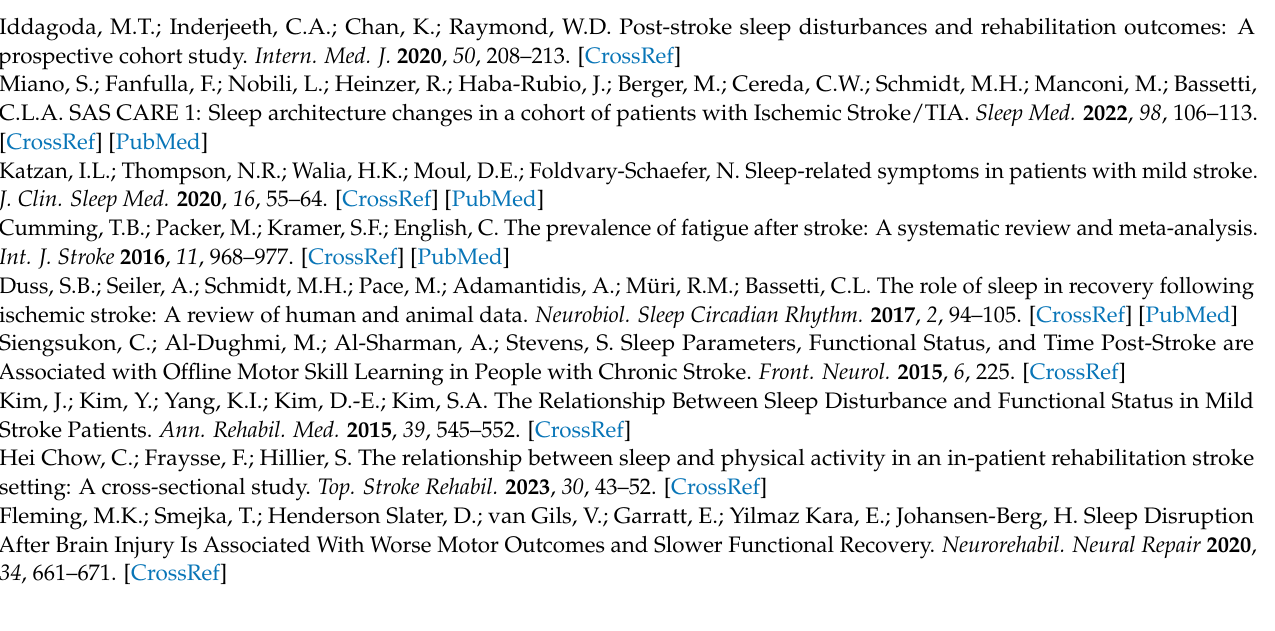
Table S1: Measure and assessment of sleep quality for Philips Actiwatch and WSA matched sub- sample participants (n = 6), raw